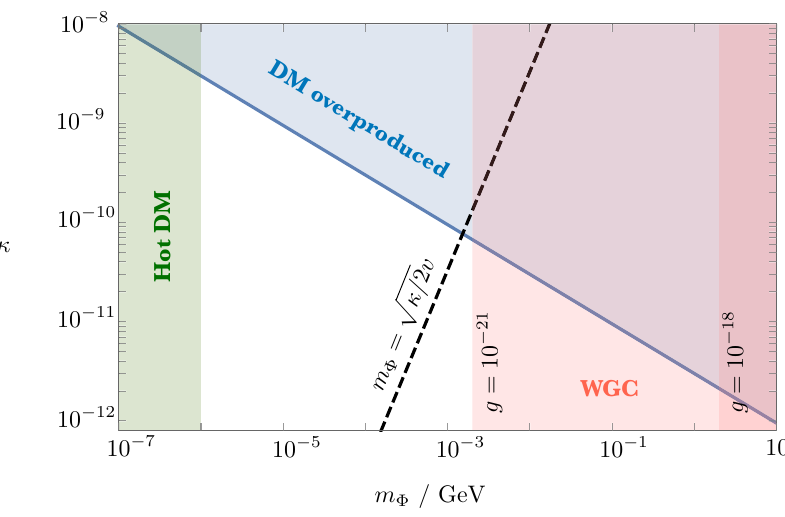
Figure 3 . Everywhere in this plot v = 246 GeV. The correct DM relic density is obtained through Higgs portal freeze-in along the horizontal blue line, as given eq. (4.2), with the region above the line corresponding to DM overproduction. The green region corresponds to m Φ (cid:31) 1 keV, and is ruled out as DM would be hot. The pink region corresponds to Φ being sub-extremal for the values of the gauge coupling g indicated in the figure, and therefore is ruled out by the WGC. The dashed line corresponds to the case m Φ = κ/ 2 v , and can therefore be considered natural (see discussion in the text), while the region to the left of this line would require (cid:31)